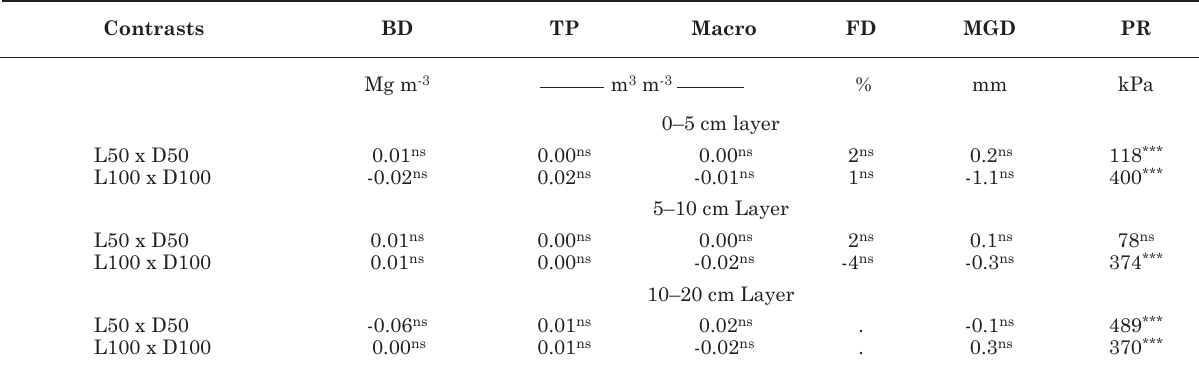
table 5. estimate 1 of the linear contrasts between treatments for physical properties of a humic cambisol amended with dreg and lime rates applied to the surface in 2004/2006. Bocaina do sul, sc, 2010